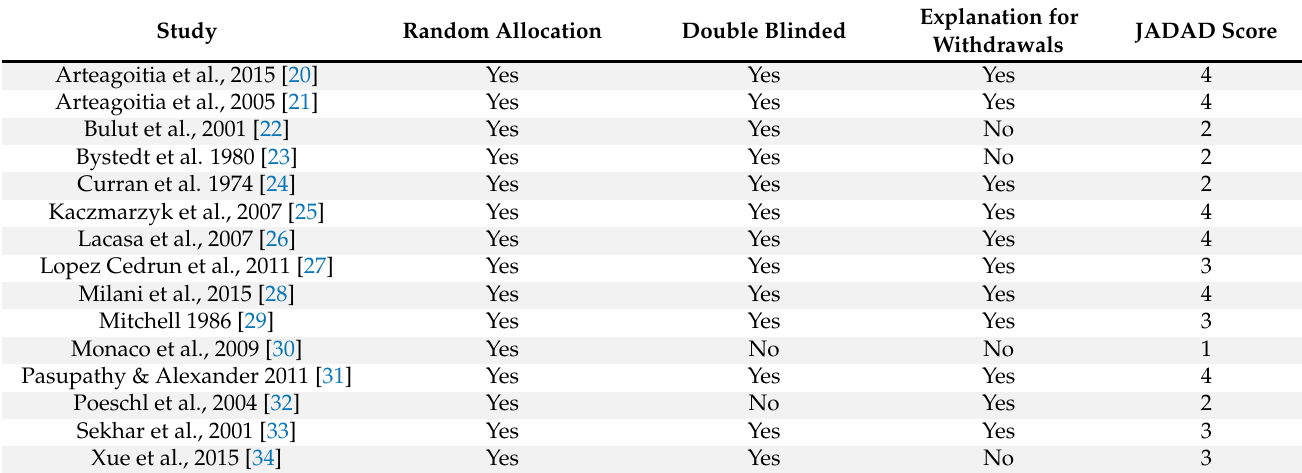
Table 3. Risk of bias of included studies.